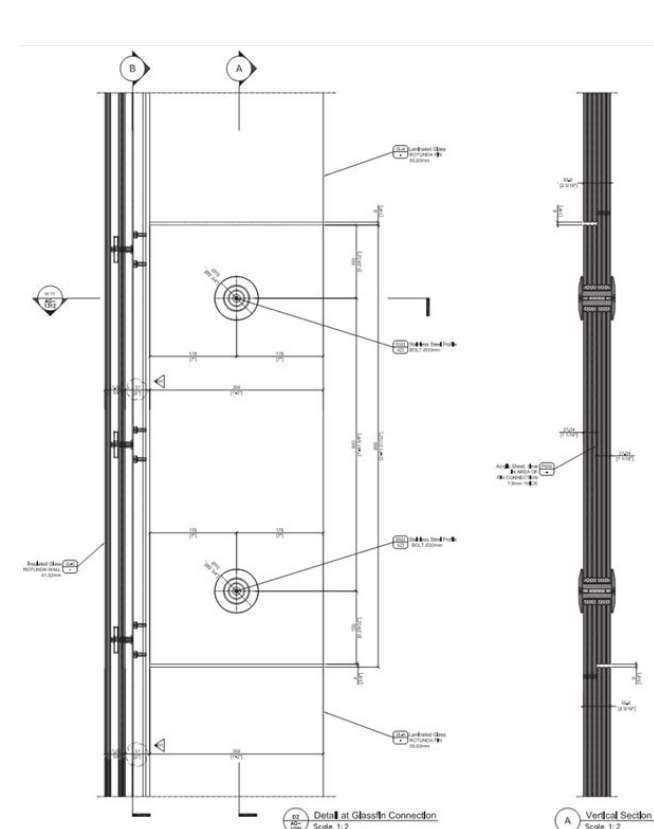
Fig. 2 Fin wall section. Fig. 3 Glass fin splice